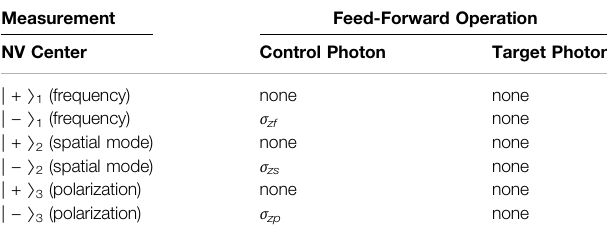
TABLE 1 | The relations between the measurement results on the NV centers and the feed-forward operations for completing a deterministic hyperparallel CPF gate working with the three DOFs of a two-photon